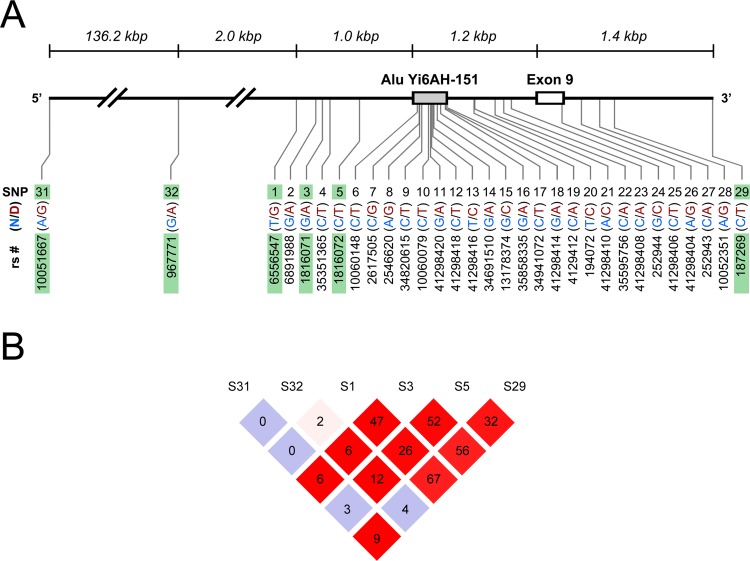
Schematic presentation of SNPs in GABRB2.(A) Positions of SNPs in GABRB2, with reference to contig NT_023133.12 and messenger RNA NM_021911. The region spans from 160,898,711 bp to 160,755,827 bp in chromosome 5. Solid black line represent introns. A flanking grey box indicates the human specific Alu insert Yi6AH-151 and a white box represents Exon 9. SNP label with ‘rs’ prefix is based on the Single Nucleotide Polymorphism database (dbSNP; www.ncbi.nih.gov/SNP). Ancestral and derived (N/D) alleles are provided for each SNP in blue and red, respectively. Six SNPs (S1, S3, S5, S29, S31, and S32) studied for heroin dependence are highlighted in green. (B) Linkage equilibrium plot of pairwise SNPs in GABRB2 in control groups. r
2 value corresponding to each SNP pair is displayed in the square (r
2 x 100). Background color of squares represents the ratio of D’ value to the log likelihood of odds ratio (LOD) corresponding to each SNP pair. Squares are colored in darker red if D’ < 1.000 and LOD ≥ 2.00, white if D’ < 1.000 and LOD < 2.0, and grey if D’ = 1.000 and LOD < 2.0.